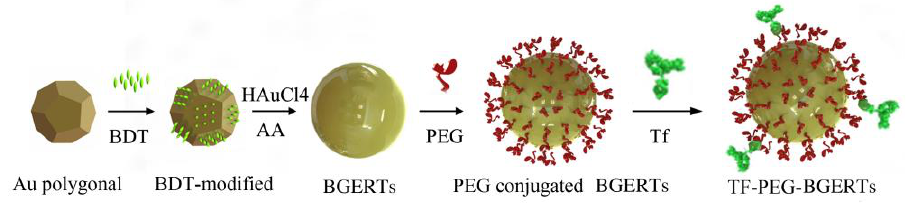
Figure 1. Sketch for preparing TF-PEG-BGERTs nanoprobe.